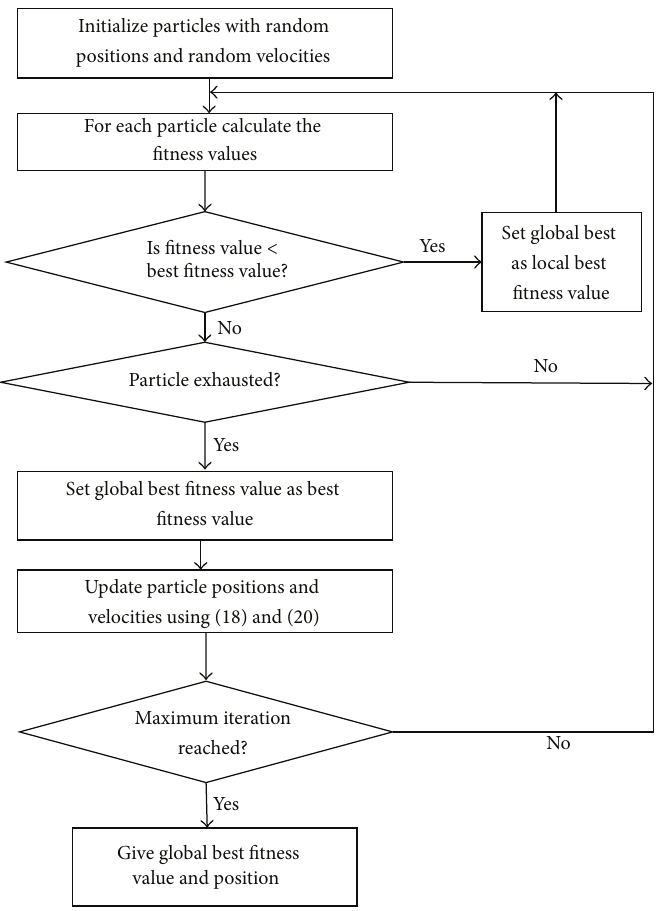
Figure 5: Flow chart of PSO